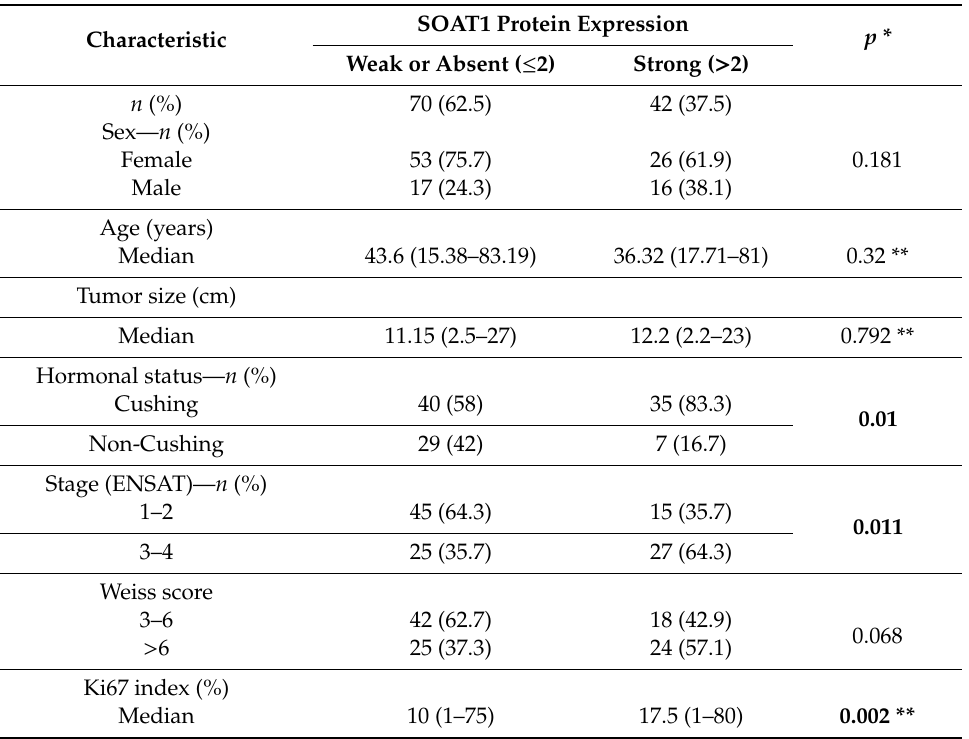
Table 2. Relationship between SOAT1 protein expression and baseline clinical and biochemical parameters, and surgical specimen histological characteristics from 112 adult patients with ACC (only tumor samples derived from primary